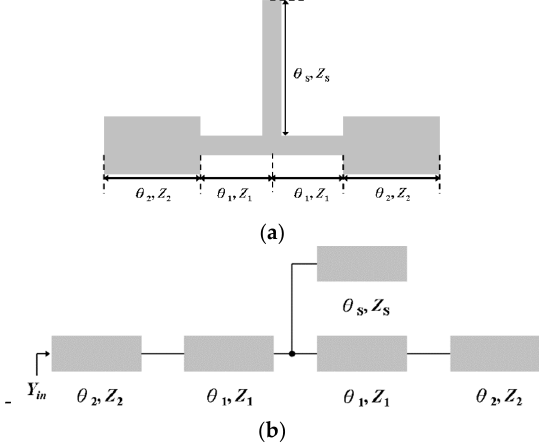
Figure 1. ( a ) The structure and ( b ) the equivalent block of the proposed stub-loaded stepped impedance resonator.